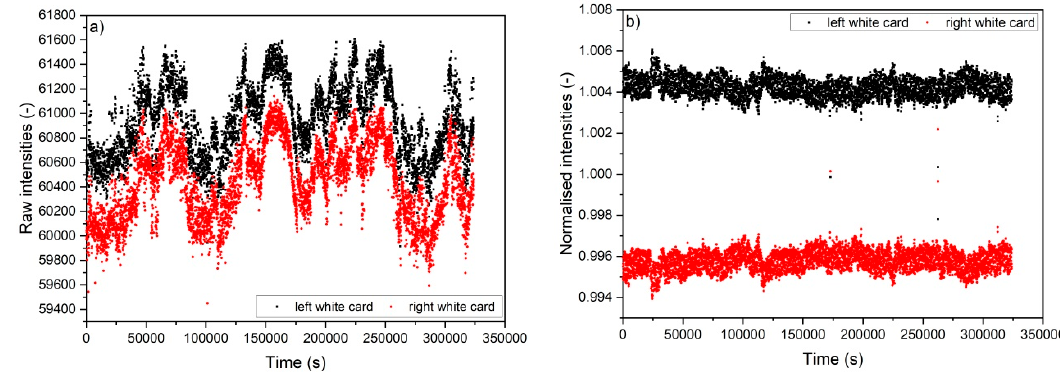
Figure 3. Evolution of the raw intensities ( a ) and normalized intensities ( b ) of white cards during the complete experiment (Green